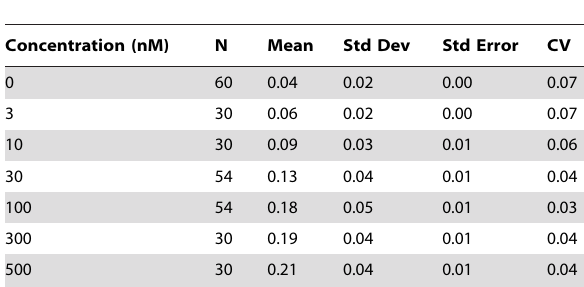
Table 4. Descriptive Statistics of Signals by Concentrations